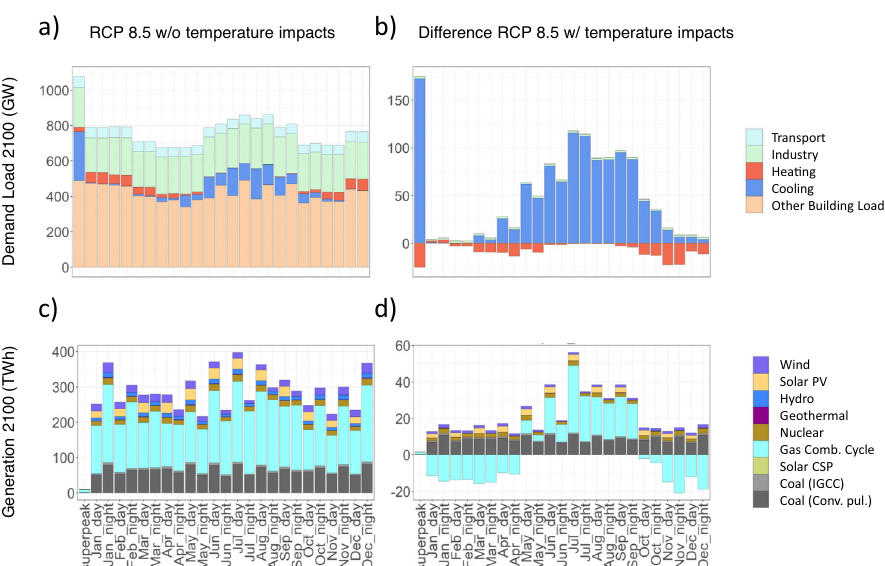
Fig. 2 Electricity demand load (GW) and generation (TWh) in 2100. a Electricity demand load (GW) by segment and end-use service in 2100 under RCP 8.5 w/o temperature impacts scenario; b Difference in electricity demand load (GW) by segment and service in 2100 under RCP 8.5 w/ temperature impacts relative to RCP 8.5 w/o temperature impacts scenario; c Electricity generation (TWh) by segment and fuel in 2100 under RCP 8.5 w/o temperature impacts scenario; d Difference in electricity generation (TWh) by segment and fuel in 2100 under RCP 8.5 w/ temperature impacts relative to RCP 8.5 w/o temperature impacts scenario. Note that scales in the four panels are different. Also, units in a and b are in GW and in c and d are in TWh.